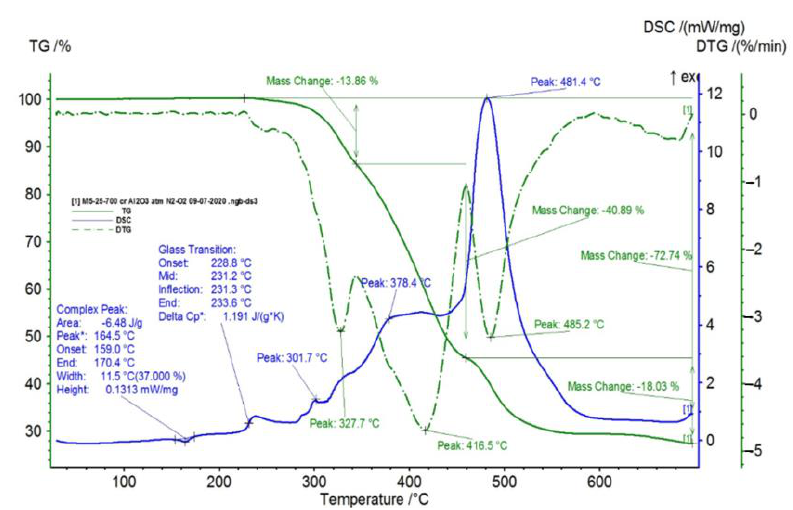
Figure 8. TG/DSC variation for sample M4.